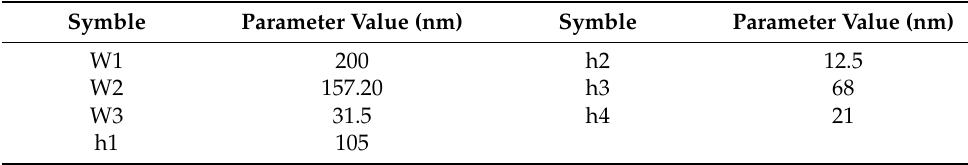
Table 1. Structural parameters of the MA unit